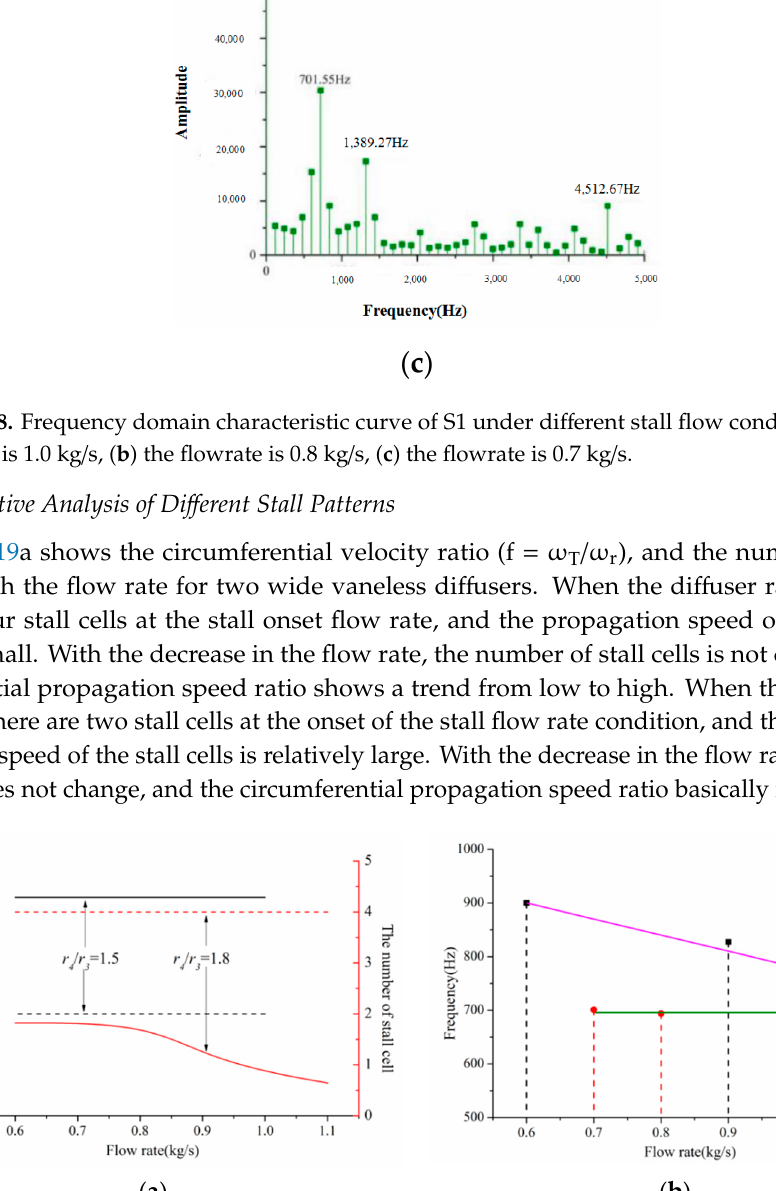
Figure 18. Frequency domain characteristic curve of S1 under different stall flow conditions: ( a ) the flowrate is 1.0 kg/s, ( b ) the flowrate is 0.8 kg/s, ( c ) the flowrate is 0.7 kg/s.